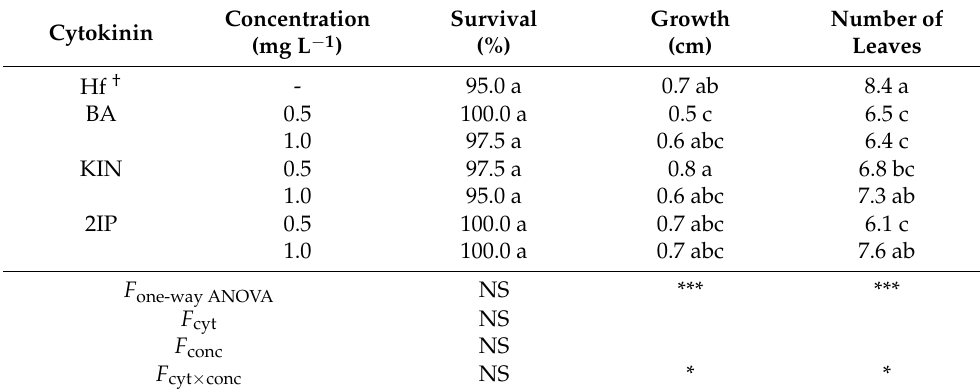
Table 2. Effect of cytokinin type and concentration on shoot proliferation from shoot explants excised from shoots produced on MS medium (Hf or containing BA at 0.5 or 1.0 mg).